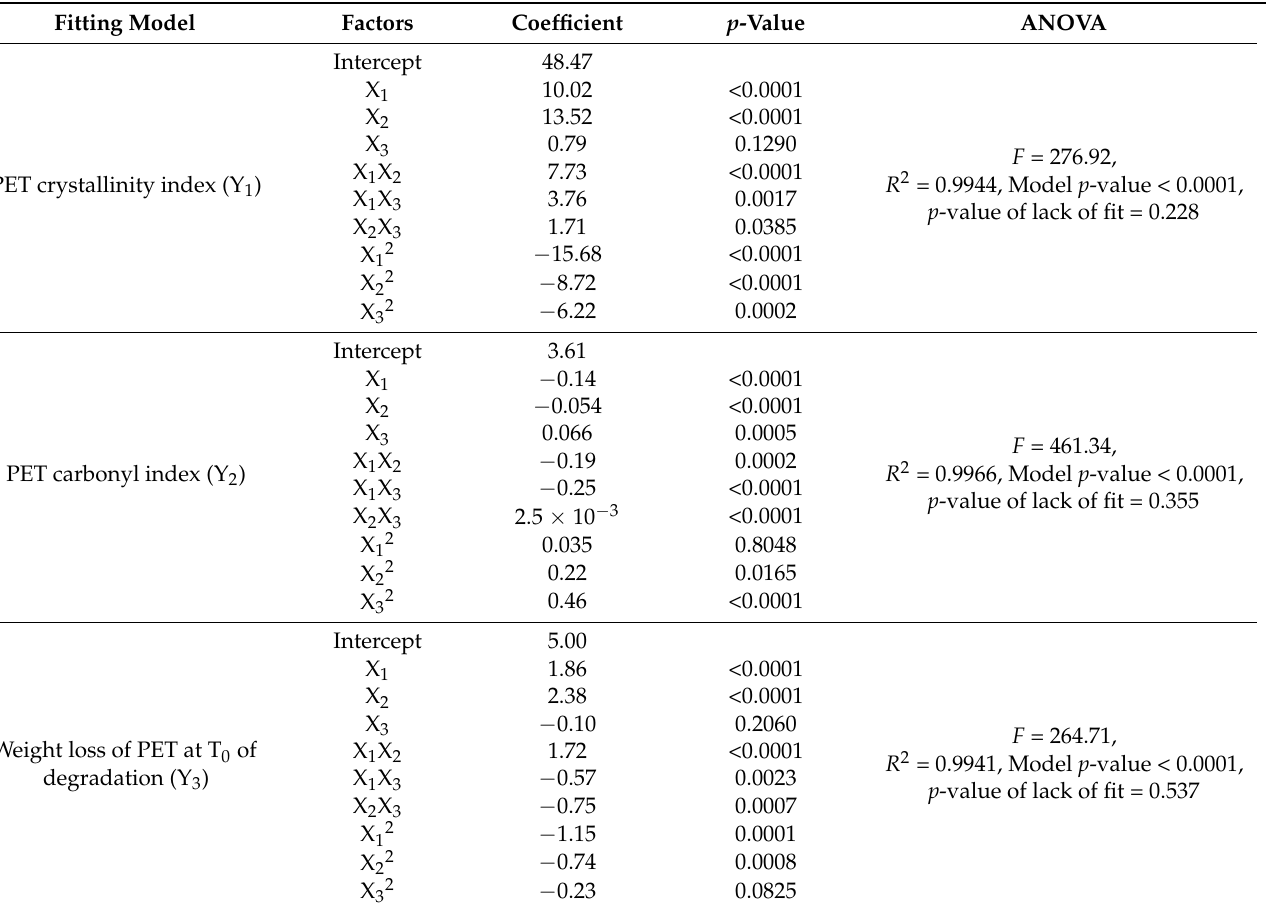
Table 3. Statistical analysis of measured responses for PET